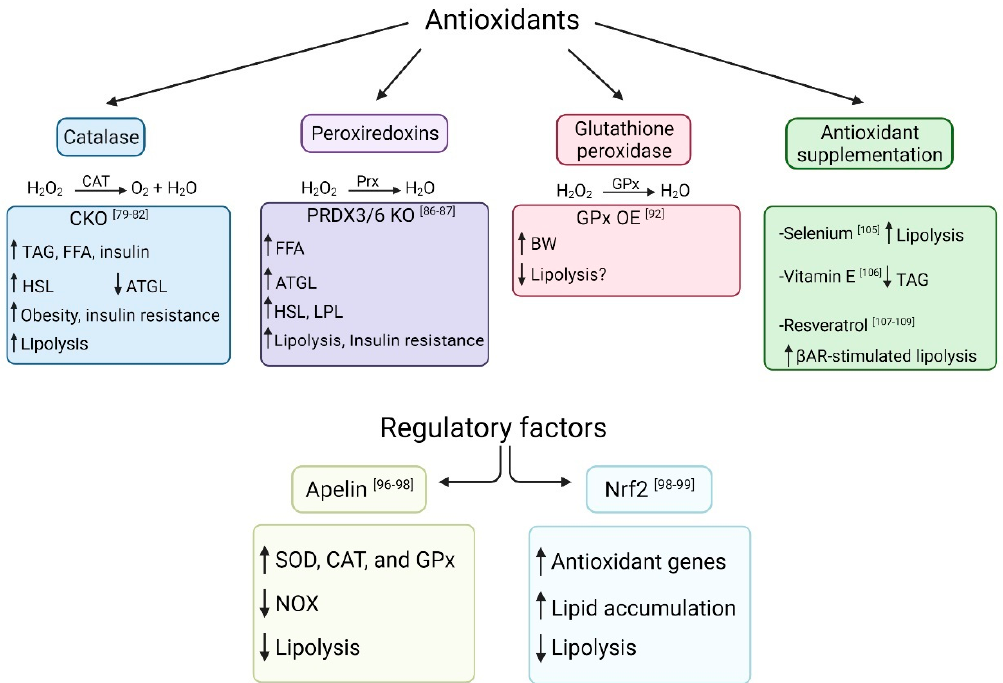
Figure 3. Antioxidant effect on lipolysis. Catalase (CAT) , an enzyme produced by peroxisomes, catalyzes the breakdown of H 2 O 2 into O 2 and H 2 O. CAT knockout models (CKO) fed a high-fat diet (HFD) have a higher lipolysis rate and are more susceptible to obesity and insulin resistance compared to wild-type littermates. Peroxiredoxins (Prx) catalyze the reduction of H 2 O 2 . Prx3/6 knockout mice (PRDX3/6 KO) have increased lipolysis and insulin resistance. Glutathione peroxidase (GPx) catalyzes the breakdown of H 2 O 2 to water. GPx overexpression results in an increase in body weight (BW) possibly by decreasing lipolysis. Selenium promotes lipolysis during obesity. Vitamin E decreases plasma triacylglycerol (TAG). Resveratrol increases β -adrenergic receptor ( β AR)-stimulated lipolysis and impairs insulin’s antilipolytic effect. Apelin decreases lipolysis by promoting the expression of antioxidant enzymes (superoxide dismutase (SOD), CAT, and GPx) and suppressing the expression of nicotinamide adenine dinucleotide phosphate oxidase (NOX). Nuclear factor E2-related factor 2 (Nrf2) increases lipid accumulation and decreases